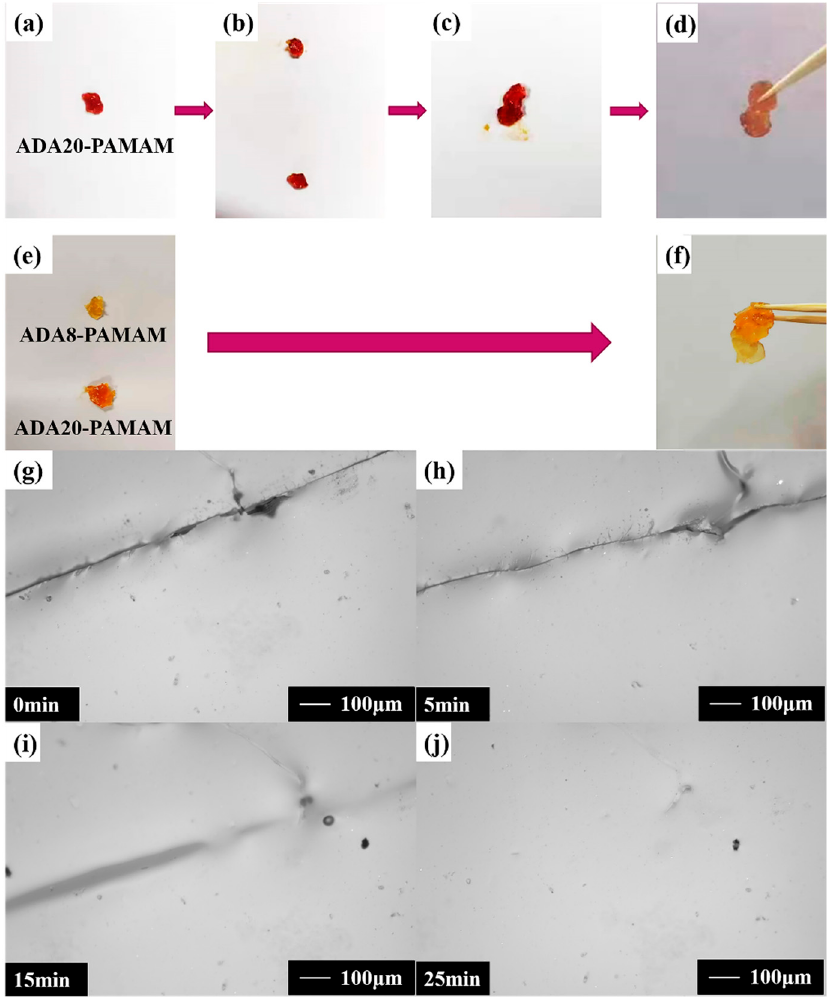
Figure 5. Self-healing ability of ADA-PAMAM with ( a – d ) the same oxidation degree (20%) and ( e , f ) different oxidation degrees (8% and 20%). Ultra-depth-of-field OM images during the self-healing process of ADA-PAMAM. ( g ) refers to the initial phase of self-healing, while ( h – j ) present the 377× magnified surface of ADA20-PAMAM after 5 min, 15 min and 25 min self-healing, respectively.